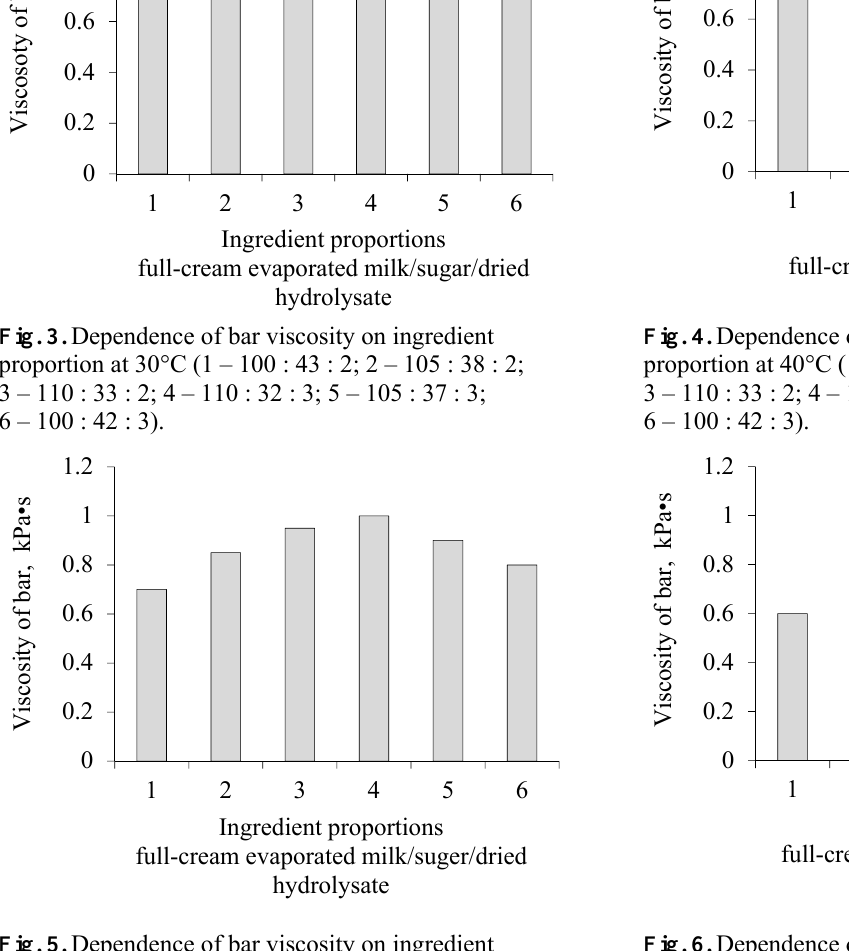
Fig. 5. Dependence of bar viscosity on ingredient Fig. 6. Dependence of bar viscosity on ingredient